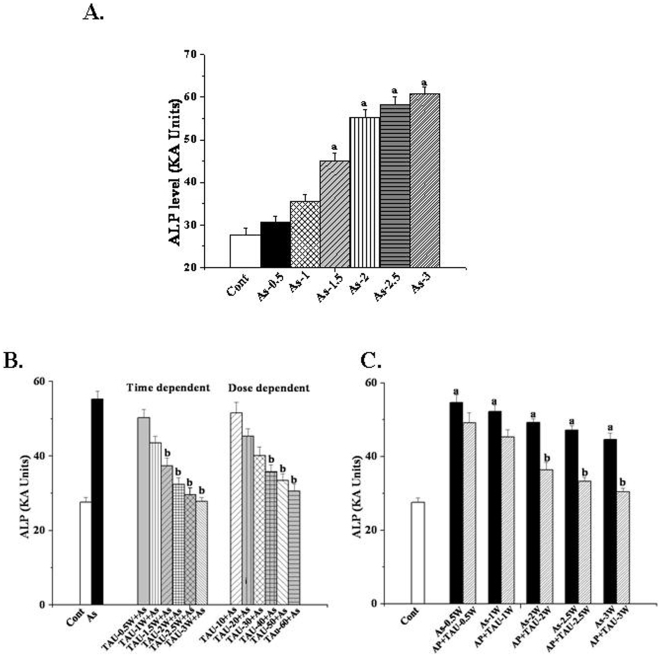
Dose and time dependant effect of NaAsO2 and taurine.Panel A: Dose dependant effect of NaAsO2 on ALP level. Cont: ALP level in normal rats; As-0.5, As-1, As-1.5, As-2, As-2.5, As-3: ALP level in NaAsO2 intoxicated rats at a dose of 0.5 mg, 1 mg, 1.5 mg, 2 mg, 2.5 mg and 3 mg/kg body weight respectively for 6 months. Panel B: Dose and time dependent effect of taurine on ALP level against arsenic induced toxicity. Cont: ALP level in normal rats, As: ALP level in NaAsO2 treated rats, TAU-10+As, TAU-20+As, TAU-30+As, TAU-40+As, TAU-50+As, TAU-60+As: ALP level in taurine (TAU) treated rats for 2 weeks at a dose of 10, 20, 30, 40, 50 and 60 mg/kg body weight prior to NaAsO2 administration; TAU-0.5W+As, TAU-1W+As, TAU-1.5W+As, TAU-2W+As, TAU-2.5W+As, TAU-3W+As: ALP level in taurine (TAU) treated rats for 0.5, 1, 1.5, 2, 2.5 and 3 weeks respectively at a dose of 50 mg/kg body weight prior to As administration. Panel C: Time dependent effect of taurine on ALP level against NaAsO2 induced toxicity in serum. Cont: ALP level in normal rats, As-0.5W, As-1W, As-2W, As-2.5W, As-3W: ALP level in NaAsO2 intoxicated rats after 0.5, 1, 2, 2.5 and 3 weeks respectively from the last dose of NaAsO2, As+TAU-0.5W, As+TAU-1W, As+TAU-1.5W, As+TAU-2.5W, As+TAU-3W: ALP level in taurine (TAU) treated rats for 0.5, 1, 2, 2.5 and 3 weeks respectively at a dose of 50 mg/kg body weight after NaAsO2 administration. Each column represents mean ± SD, n = 6. “a” indicates the significant difference between the normal control and As intoxicated groups and “b” indicates the significant difference between taurine post-treated and recovery groups. (Pa<0.05, Pb<0.05).